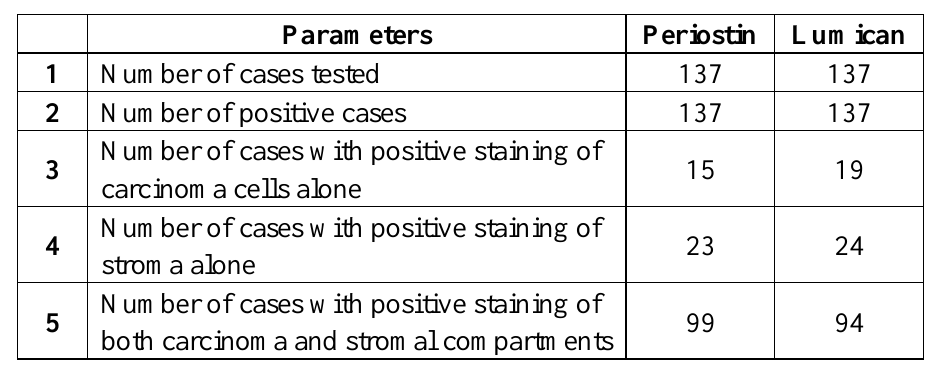
Table 1. Expression pattern of periostin and lumican among ESCC